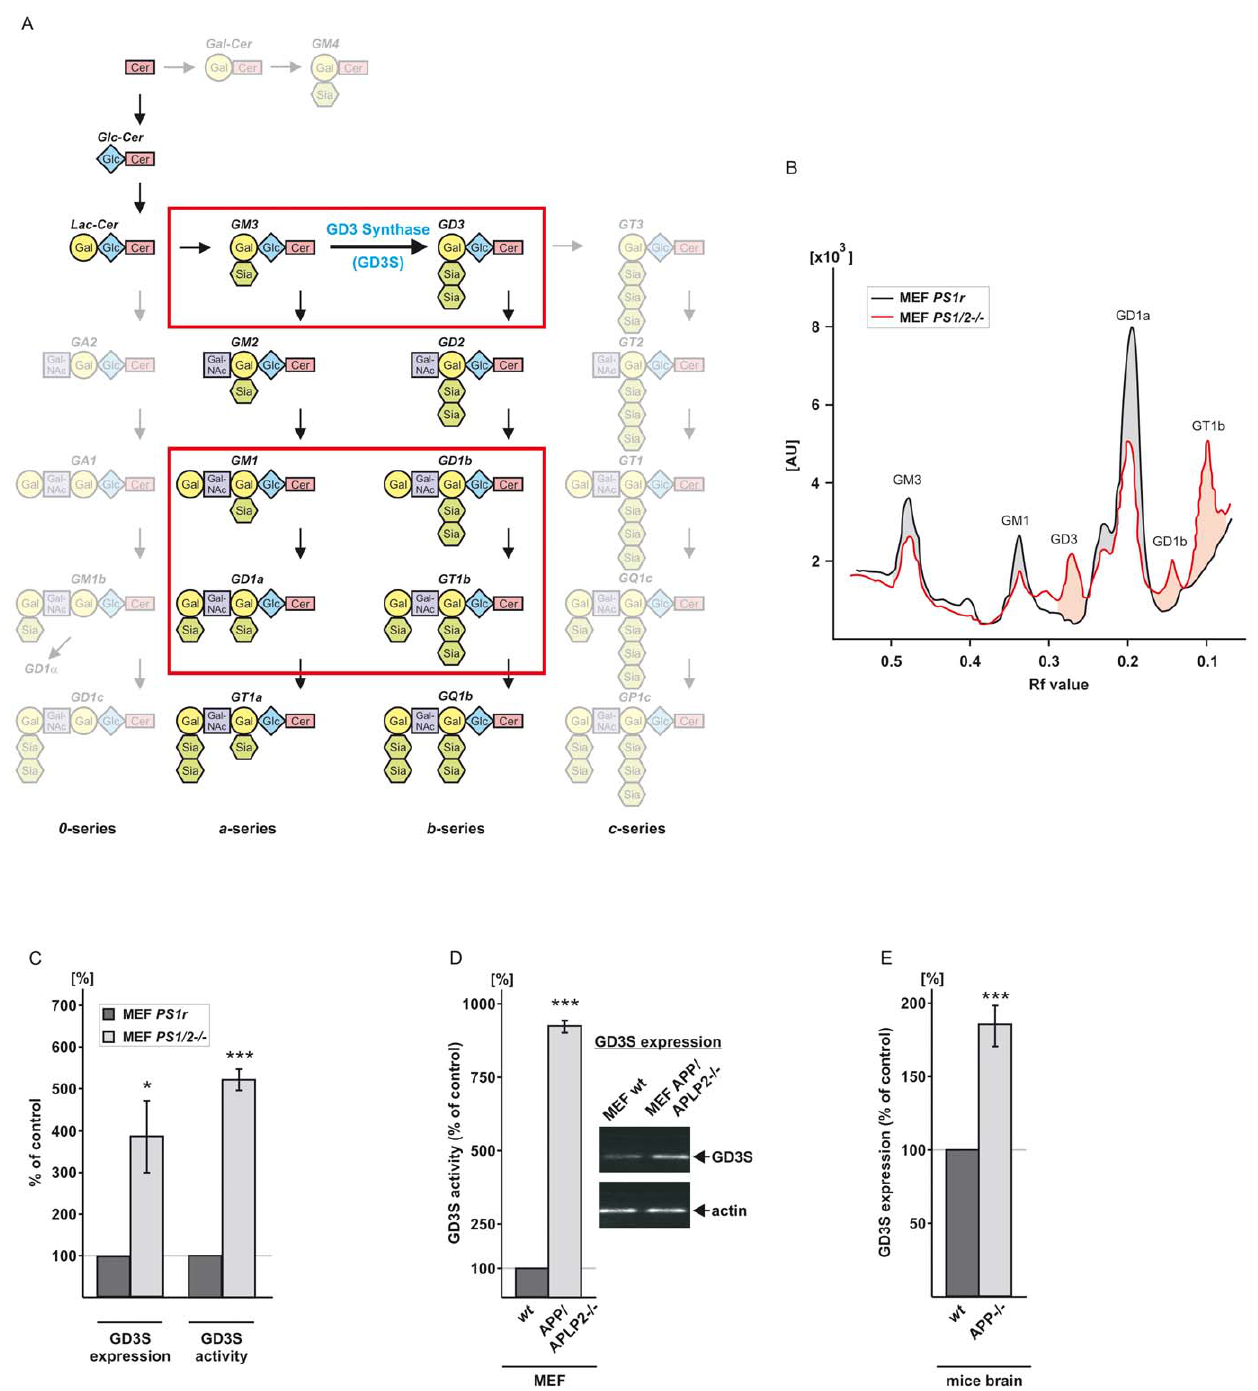
Figure 1. Ganglioside biosynthesis and effects on GD3s in dependence of APP-processing. ( A ) Biosynthetic pathway of ganglio-series gangliosides is shown. GD3-synthase (GD3S) converts GM3 to GD3 by adding sialic acid to GM3, generating the b -series of gangliosides. The major brain gangliosides GM1, GD1a, GD1b and GT1b are highlighted. ( B ) TLC analysis of a - and b -series gangliosides in PS-deficient cells. Representative densiometric quantification of TLC, analyzing the ganglioside pattern in PS1/2 deficient mouse embryonic fibroblasts (MEF PS1/2-/-) and MEF PS1/2-/- retranfected with PS1 wildtype (MEF PS1r). Peaks were identified by external standard and Rf-value. ( C ) GD3S expression and activity in PS1/2- deficient cells. In accordance with the altered b : a ratio of gangliosides, GD3S expression and activity is increased in PS-deficient cells (MEF PS1/2-/-) compared to MEF PS1r. ( D ) Analysis of GD3S activity and GD3S expression in APP/APLP2-deficient mouse embryonic fibroblasts (MEF APP/APLP2-/-) compared to wildtype mouse embryonic fibroblasts (MEF wt). MEF APP/APLP2-/- show increased GD3S activity and enhanced corresponding GD3S expression, analyzed by quantitative real-time PCR. ( E ) In vivo analysis of GD3S expression in brains of APP-deficient mice (APP-/-) show increased GD3S gene transcription compared to wt mice.